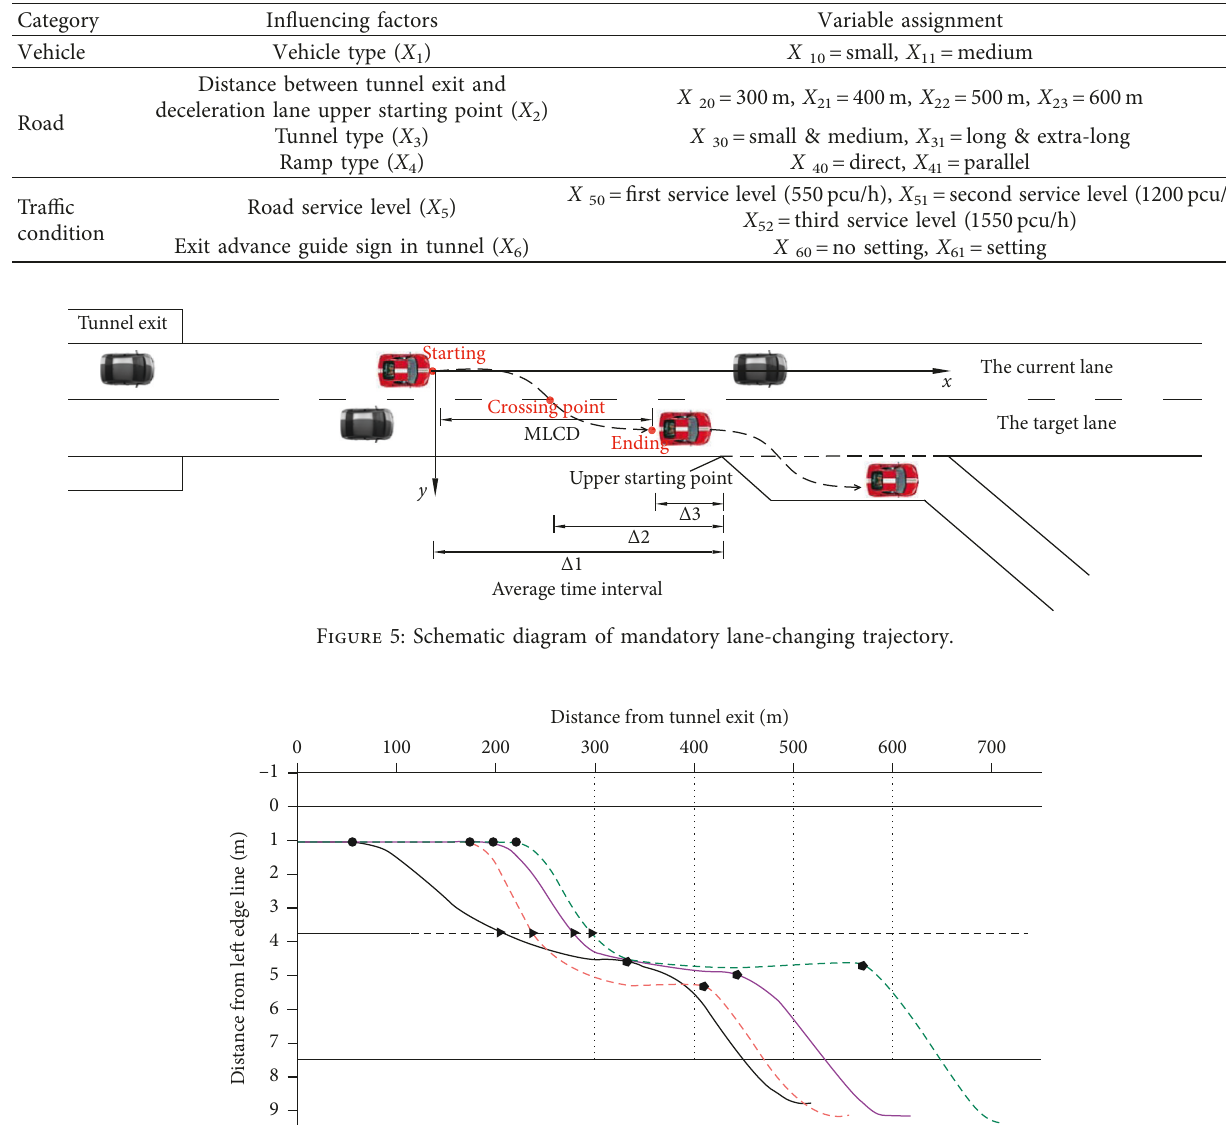
Table 3: Influencing factors and variable assignments.